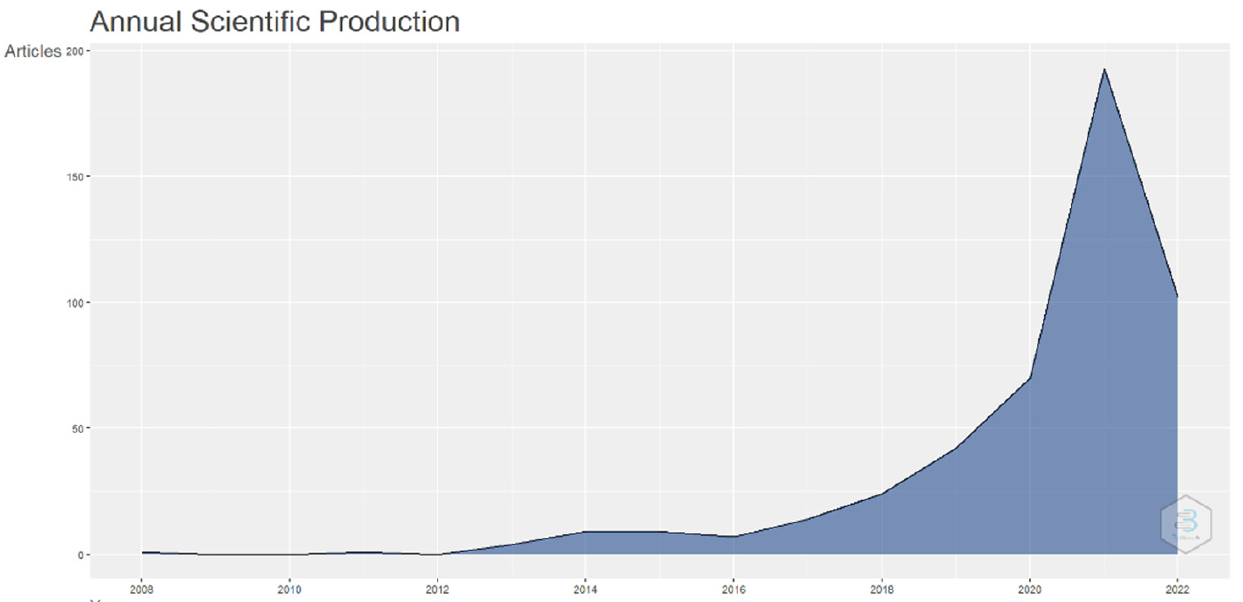
Figure 1. Methodological flow. Source: Own elaboration.